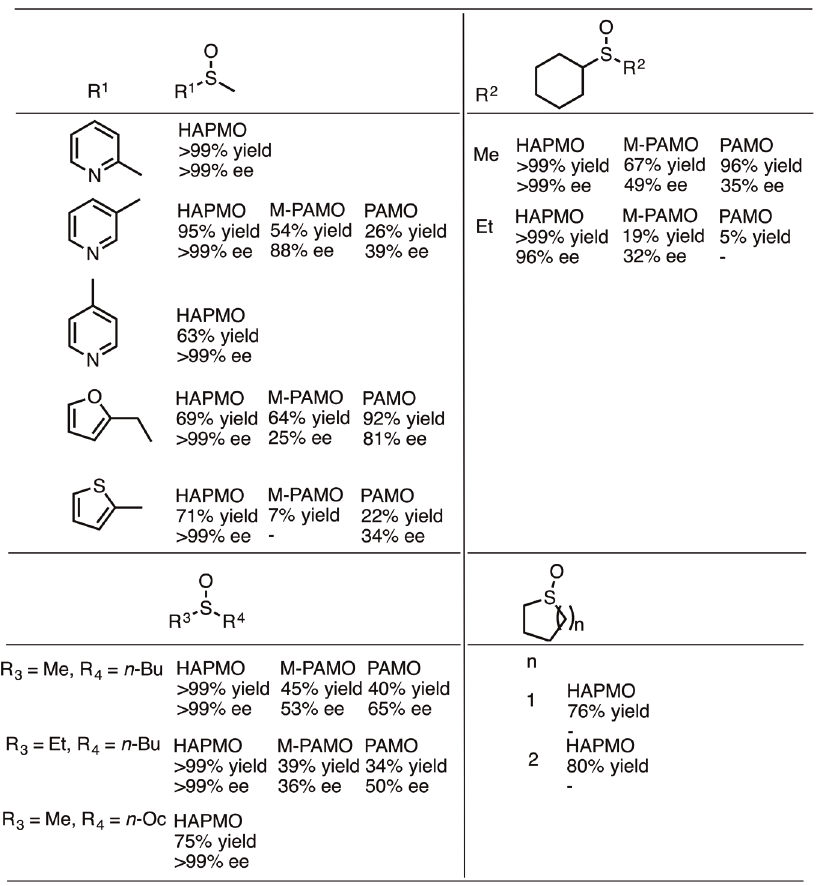
Figure 16 - Use of BVMOs (HAPMO, M-PAMO and PAMO) described by Rioz-Martínez et al. (2010) to produce